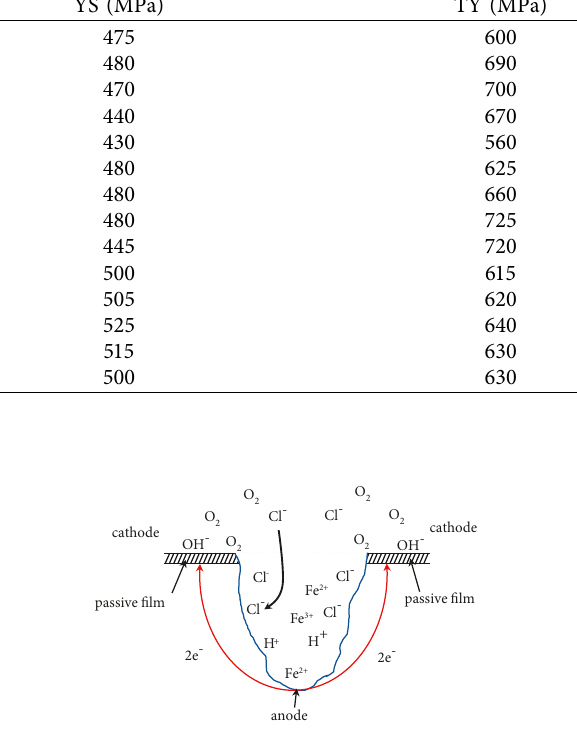
Figure 8: Schematic diagram of the pit formation in the ferrite